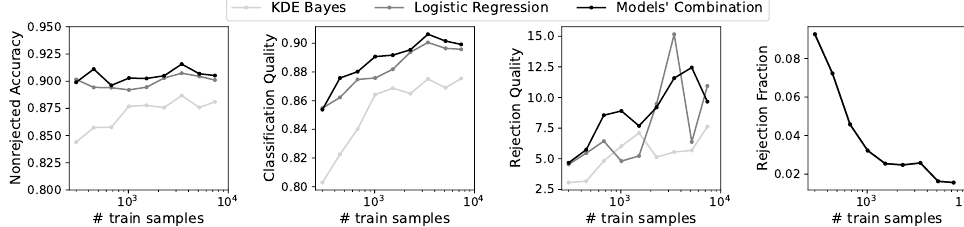
Figure 12. Performance measures for classification with rejection for different training